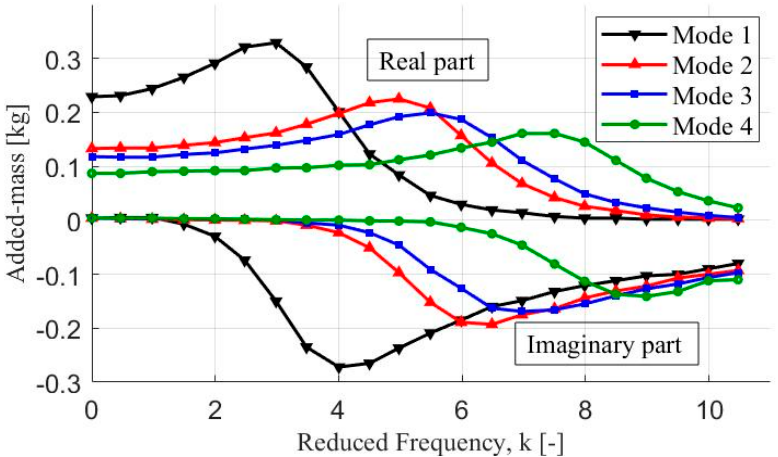
Figure 7. Added mass terms as function of reduced frequency for trapezoidal simply supported plate.